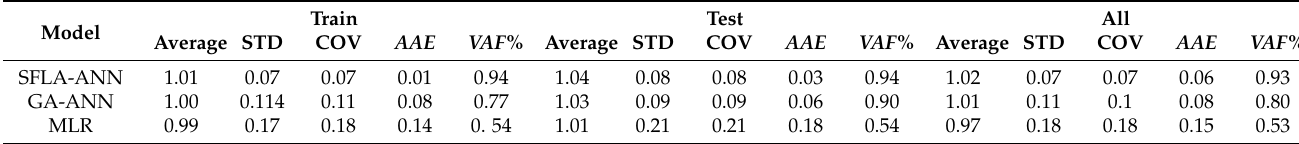
Table 9. Statistics of the developed